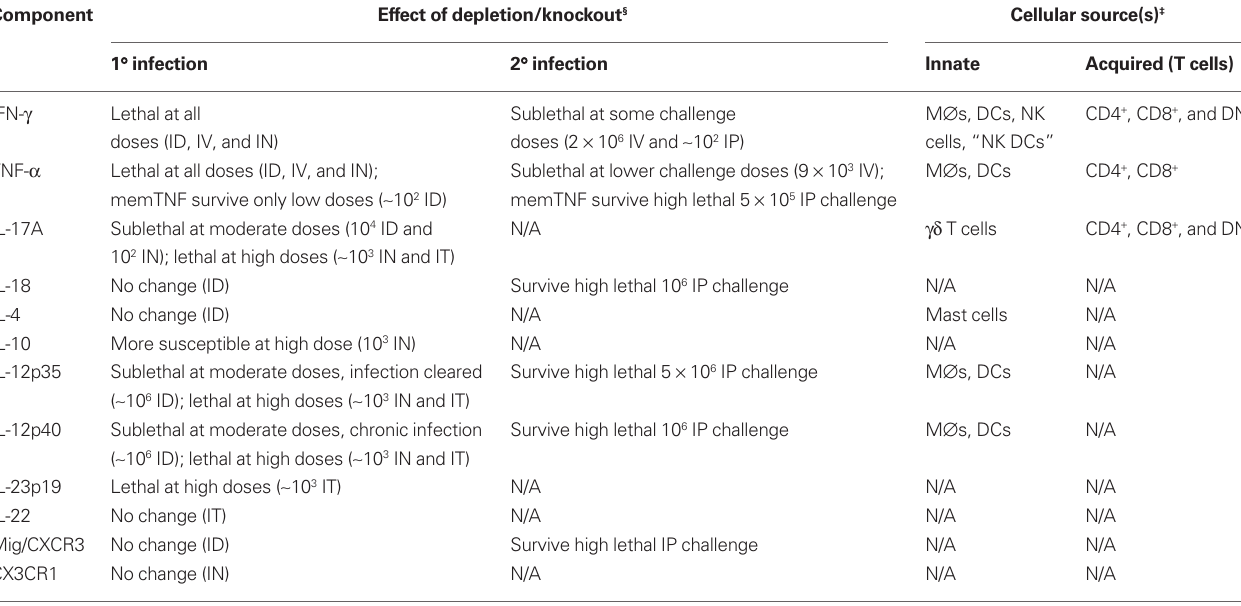
Table 3 | The contribution of cytokines and chemokines to in vivo murine infection with Francisella tularensis *.